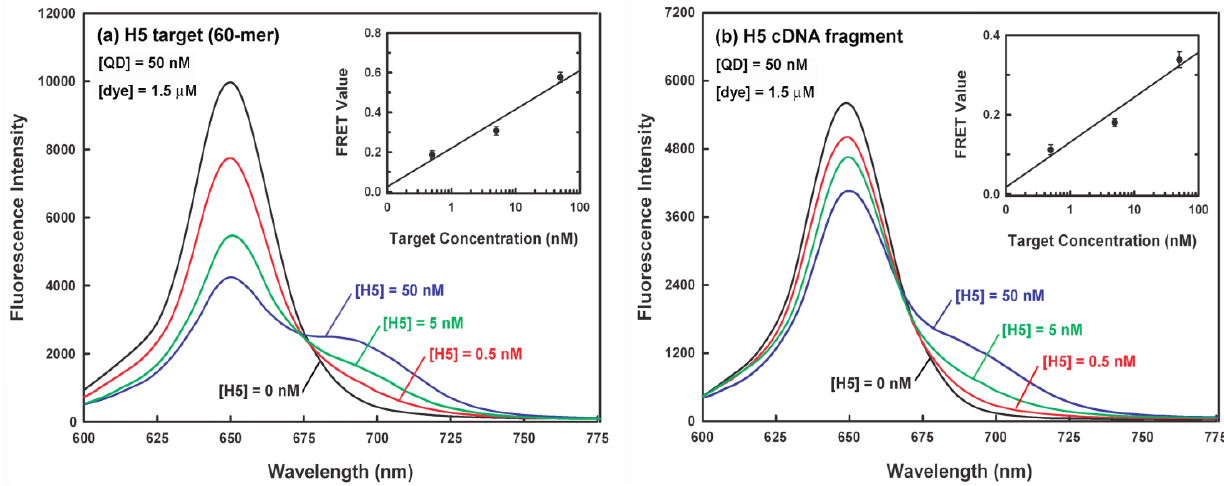
Figure 6. FRET detection of different amounts of ( a ) 60-mer H5 target (0–50 nM) and ( b ) 630-nt H5 cDNA fragment target (0–50 nM) with 50 nM FRET donor (QD) and 1.5 μ M FRET acceptor (dye). The insets of ( a ) and ( b ) display the dose response relationship between the average FRET value from triplicate experiments and the target